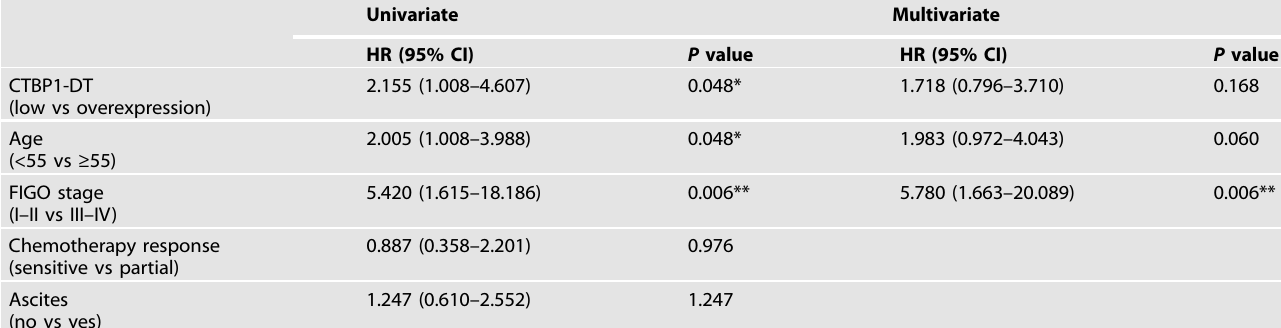
Table 2. Univariate and multivariate analyses of the associations between HGSOC patient risk